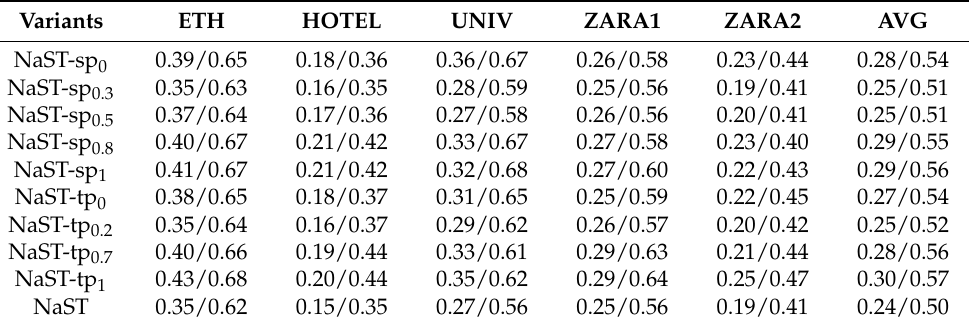
Table 3. The results of different extent of spatial and temporal sparsity on ETH and UCY datasets of ADE/FDE metrics (the lower numerical result is